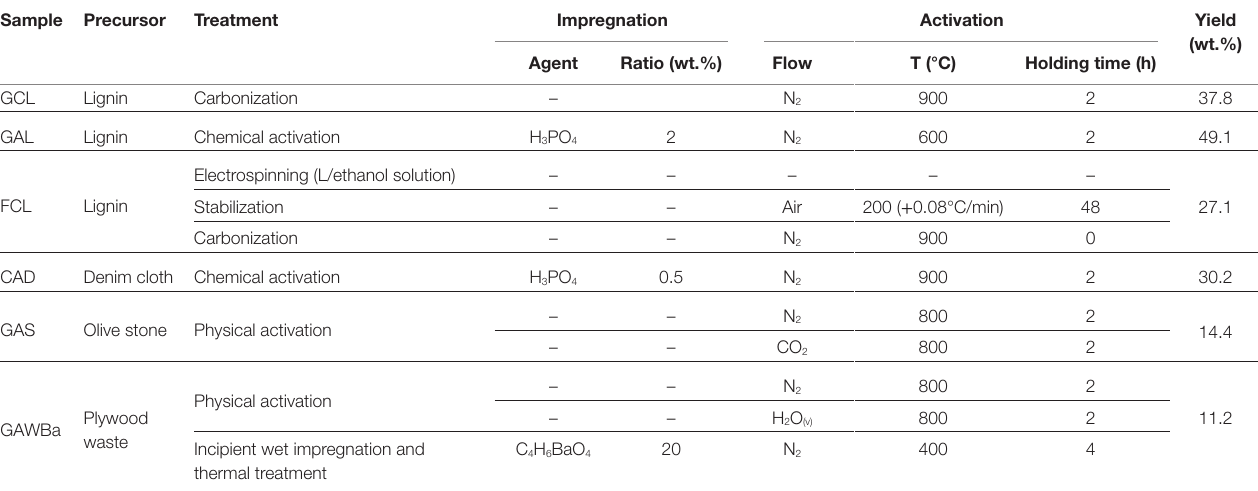
TaBle 1 | notation and activation conditions of the different carbonaceous materials studied. sample